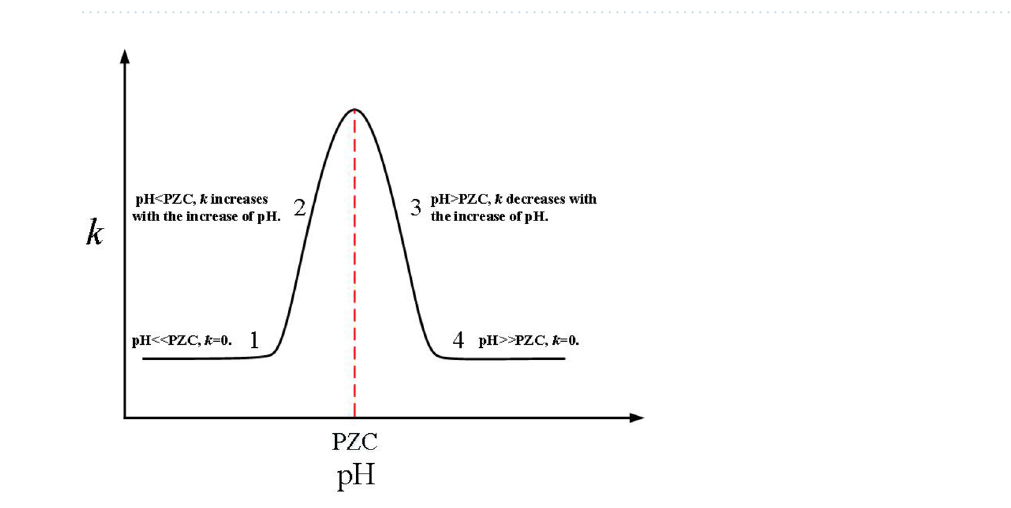
Figure 2. Theoretical prediction diagram of the change of colloidal aggregation rate constant, k , with pH 5